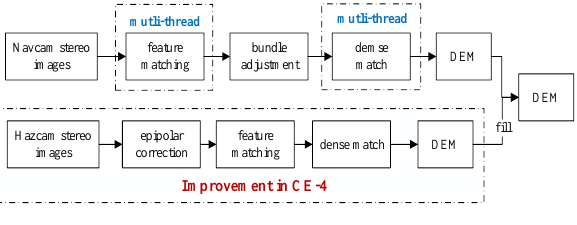
Figure 4. Flowchart of terrain reconstruction for